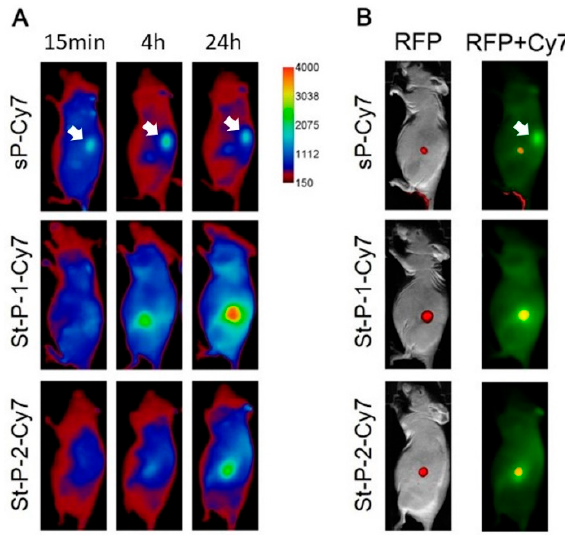
Figure 5. Passive tumor accumulation of di ff erent molecular weight polymer probes sP-Cy7, St-P-1-Cy7 and St-P-2-Cy7. White arrow shows kidney. ( A ) Cy-7 fluorescence signal in representative mice at three di ff erent times; ( B ) RFP signal after 24 h post injection from red fluorescent protein (RFP)-expressing tumor cells in red and Cy-7 fluorescence signal in green. Number of mice n = 8.